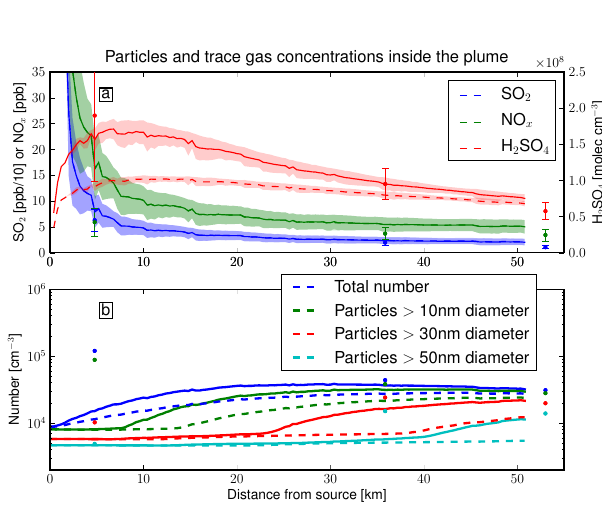
Fig. 10. (a) Trace gases and (b) particle number vs. distance down- wind from the Parish power plant averaged over the plume for dif- fering rates of OH production due to different assumptions of VOC concentrations. Dots are aircraft observations; lines are model re- sults. Shaded area and error bars indicate one standard deviation in concentration across plume width. The results of the high-VOC case are shown as a solid line, and the results of the low- VOC case are shown as a dashed line. Model resolution is 400 × 400 ×